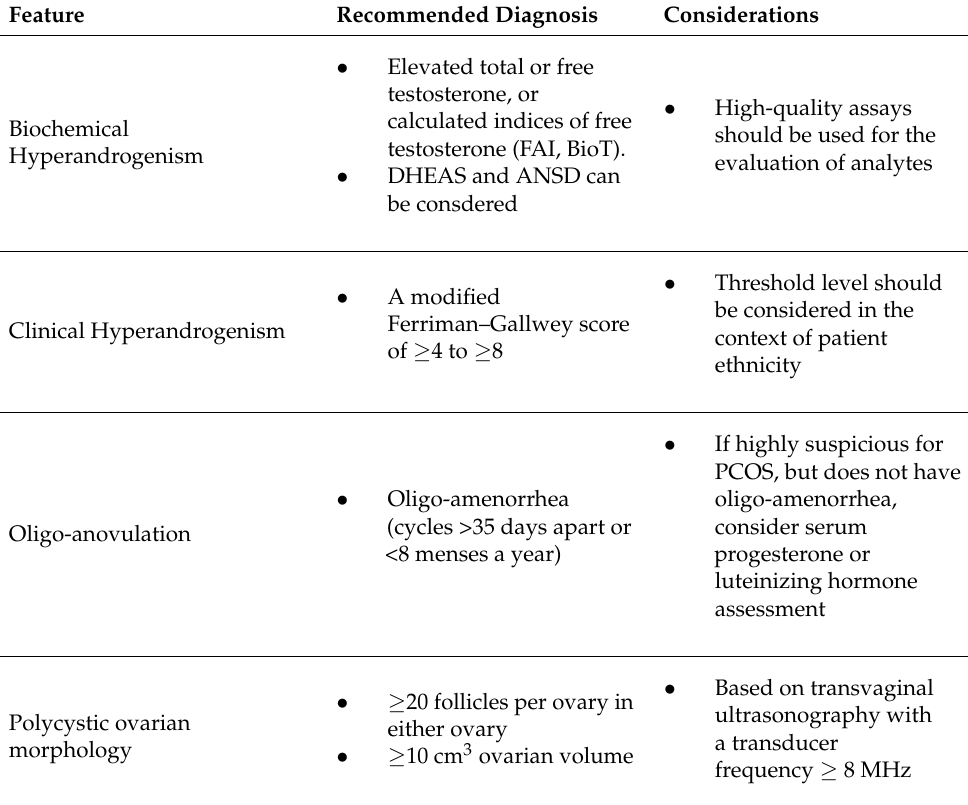
Table 1. Features of the diagnosis of